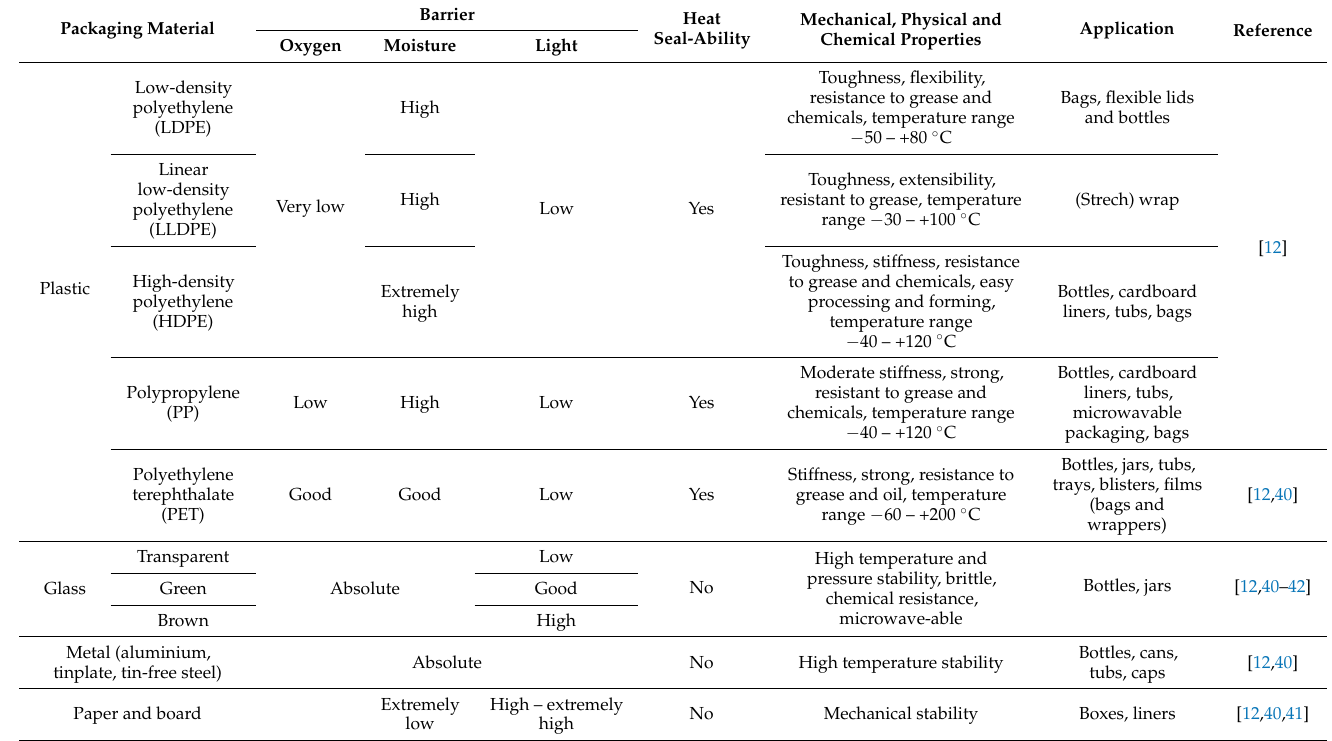
Table 1. Overview of the properties and applications of most widely used materials for